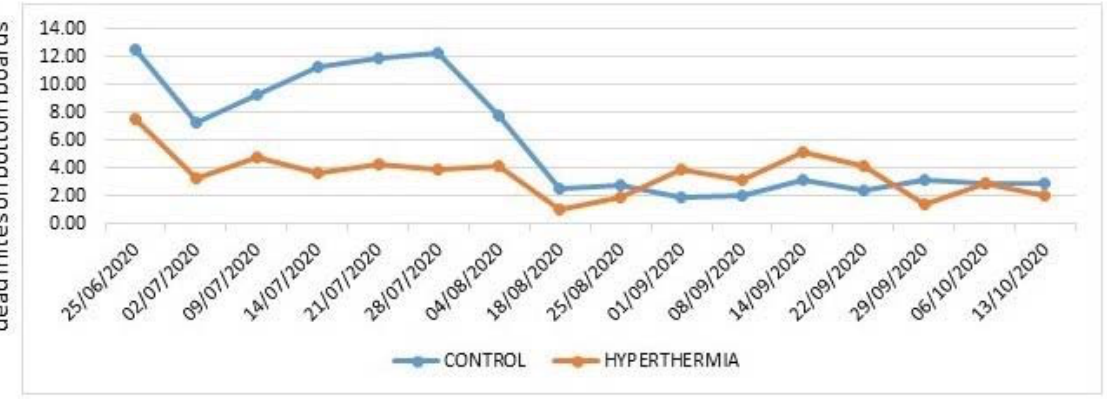
Figure 5. Average daily Varroa destructor mortality in 2020.